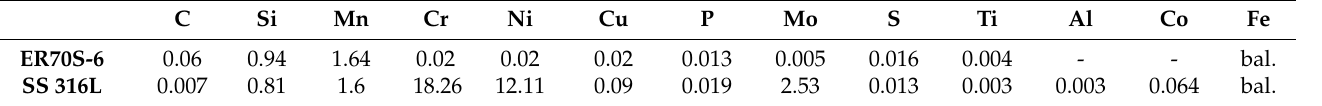
Table 1. Composition of welding wires used in multi-material parts